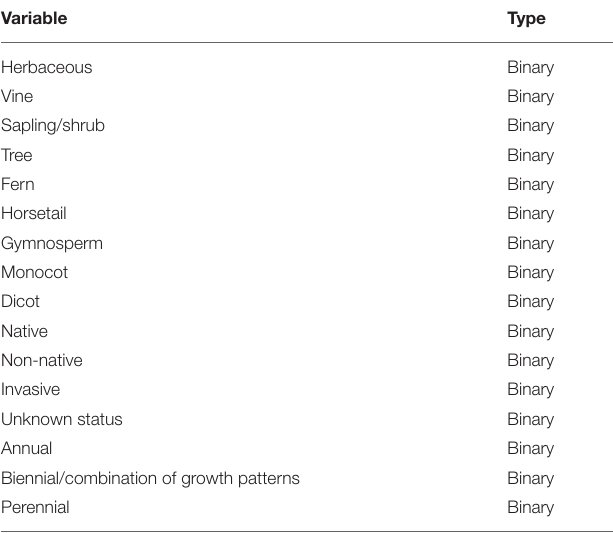
TABLE 2 | Trait variables for plant